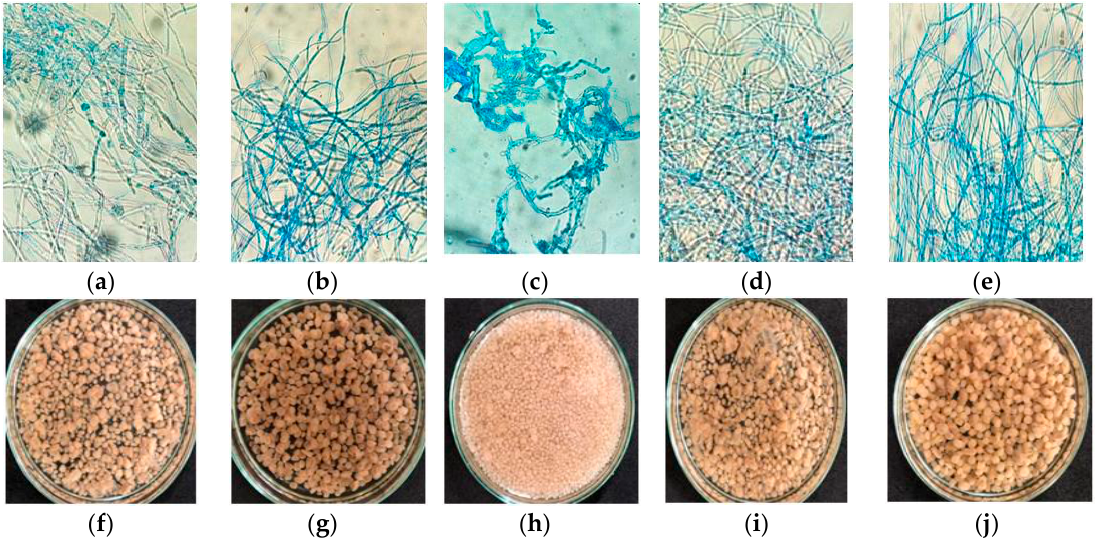
Figure 2. Morphological aspects of Lichtheimia hyalospora UCP 1266 cultivated in different concentrations of CSL and CWW according to the 2 2 factorial design for 120 h. ( a , f ): Assay 1; ( b , g ): assay 2; ( c , h ): assay 3; ( d , i ): assay 4; ( e , j ): center point. * Assay 1: 2% CSL and 4% CWW; assay 2: 6% CSL and 4% CWW; assay 3: 2% CSL and 8% CWW; assay 4: 6% CSL and 8% CWW; center point: 4% CSL and 6% CWW. Bars: 10 μ m.